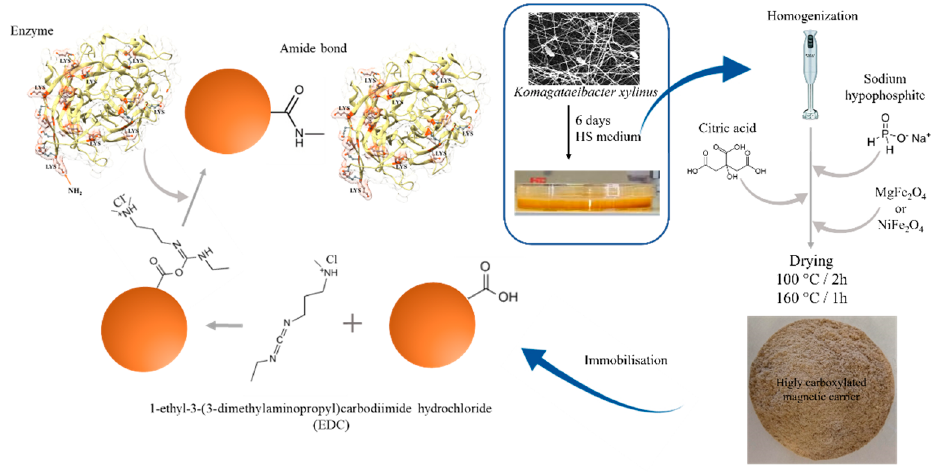
Figure 10. The schema of carrier preparation and enzymes immobilization process.